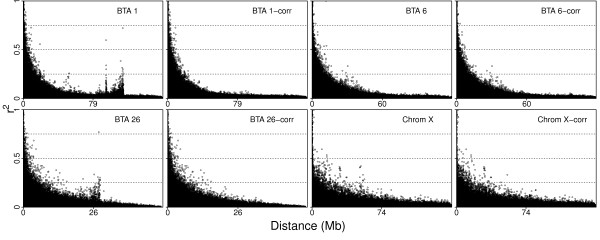
Decay of r2 as function of physical distance. The plots represent pairwaise LD on chromosomes 1, 6, 26 and X before and after (corr) positions of the misplaced SNPs were corrected.